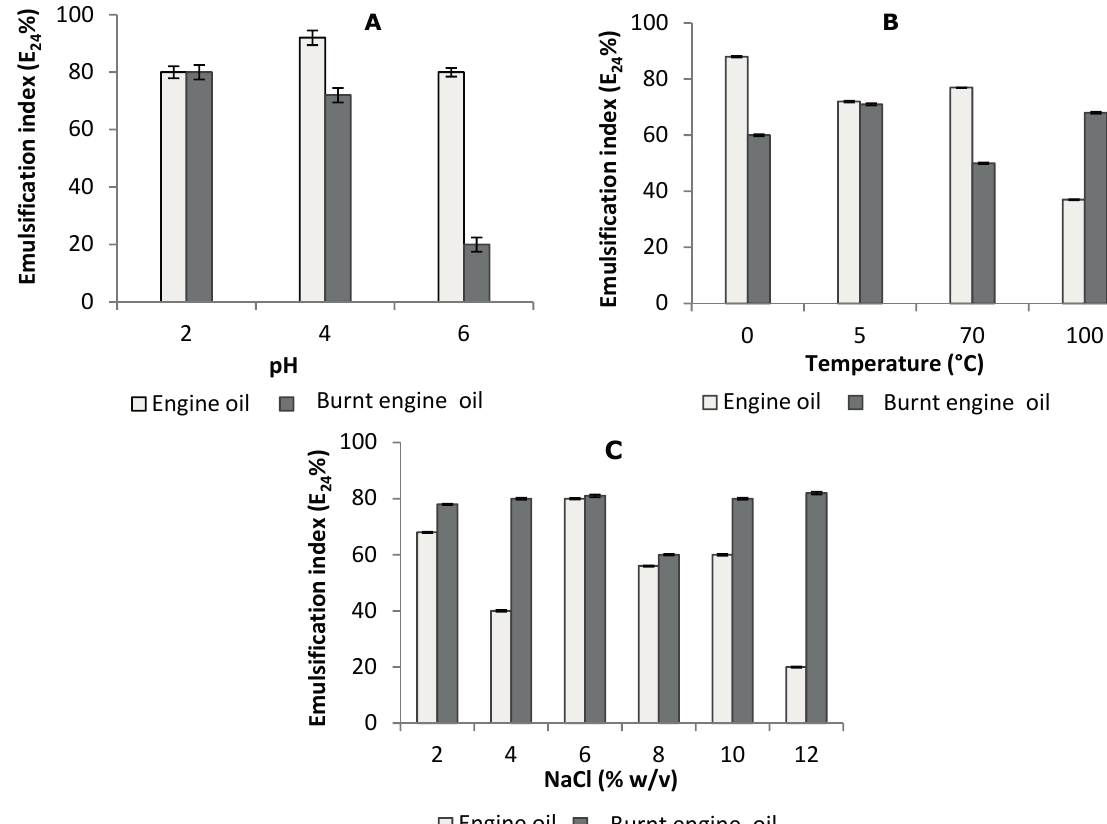
Figure 5. Stability of bioemulsifier of the biosurfactant produced by Cunninghamella echinulata using CSL (corn steep liquor) and SOW (soybean oil waste). Studies of the effect of pH ( A ); temperature ( B ); and sodium chloride concentrations ( C) on emulsifier index (E 24